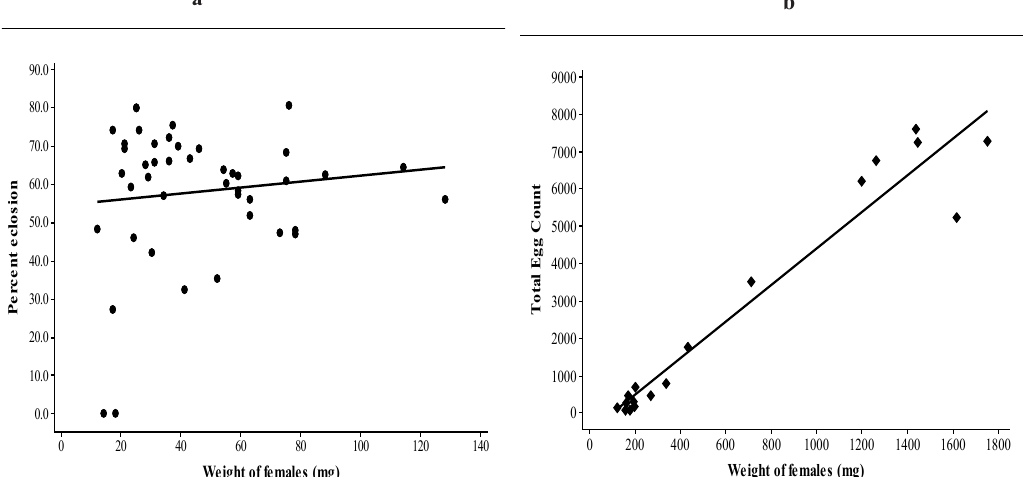
Figure 5: Total egg counts vs. weight of R. microplus females (regression fit; a:R 2 - 95.4%: Y= 0.079X + 10.12) and H. isaaci females (b:R 2 - 85.0%: Y= 0.066X + 48.78).